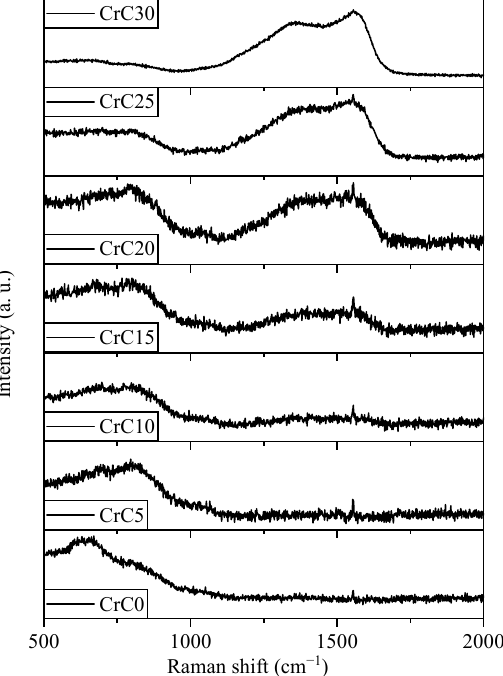
Figure 6. Normalized Raman spectra of CrC coatings deposited at different C 2 H 2 flow rates.